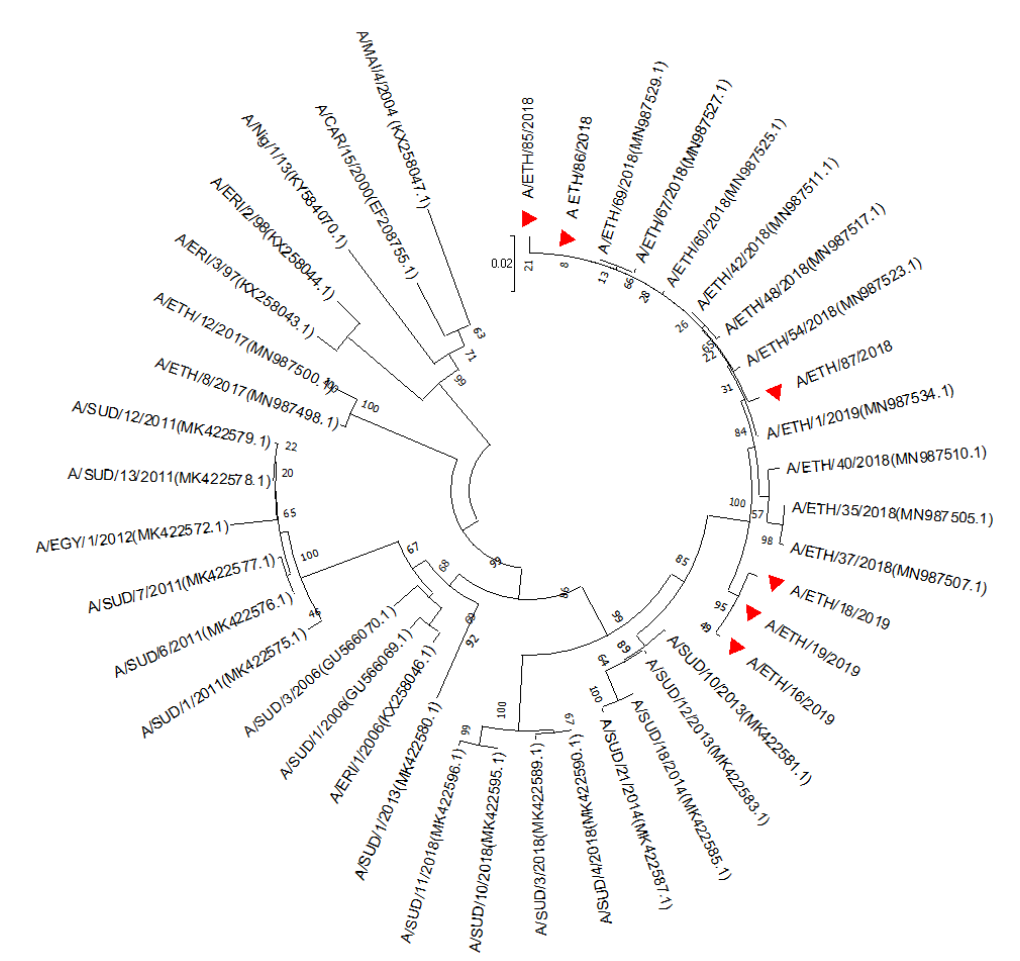
Figure 3. Mid-point-rooted neighbor-joining phylogenetic tree of serotype A FMDV isolates in comparison with serotype A isolates from Ethiopia and other reference countries. New isolates from Guduru, Kuyu, Fitche, and Muketuri of Oromia Region are indicated by ( ) topotypes: A/Africa/G-IV.